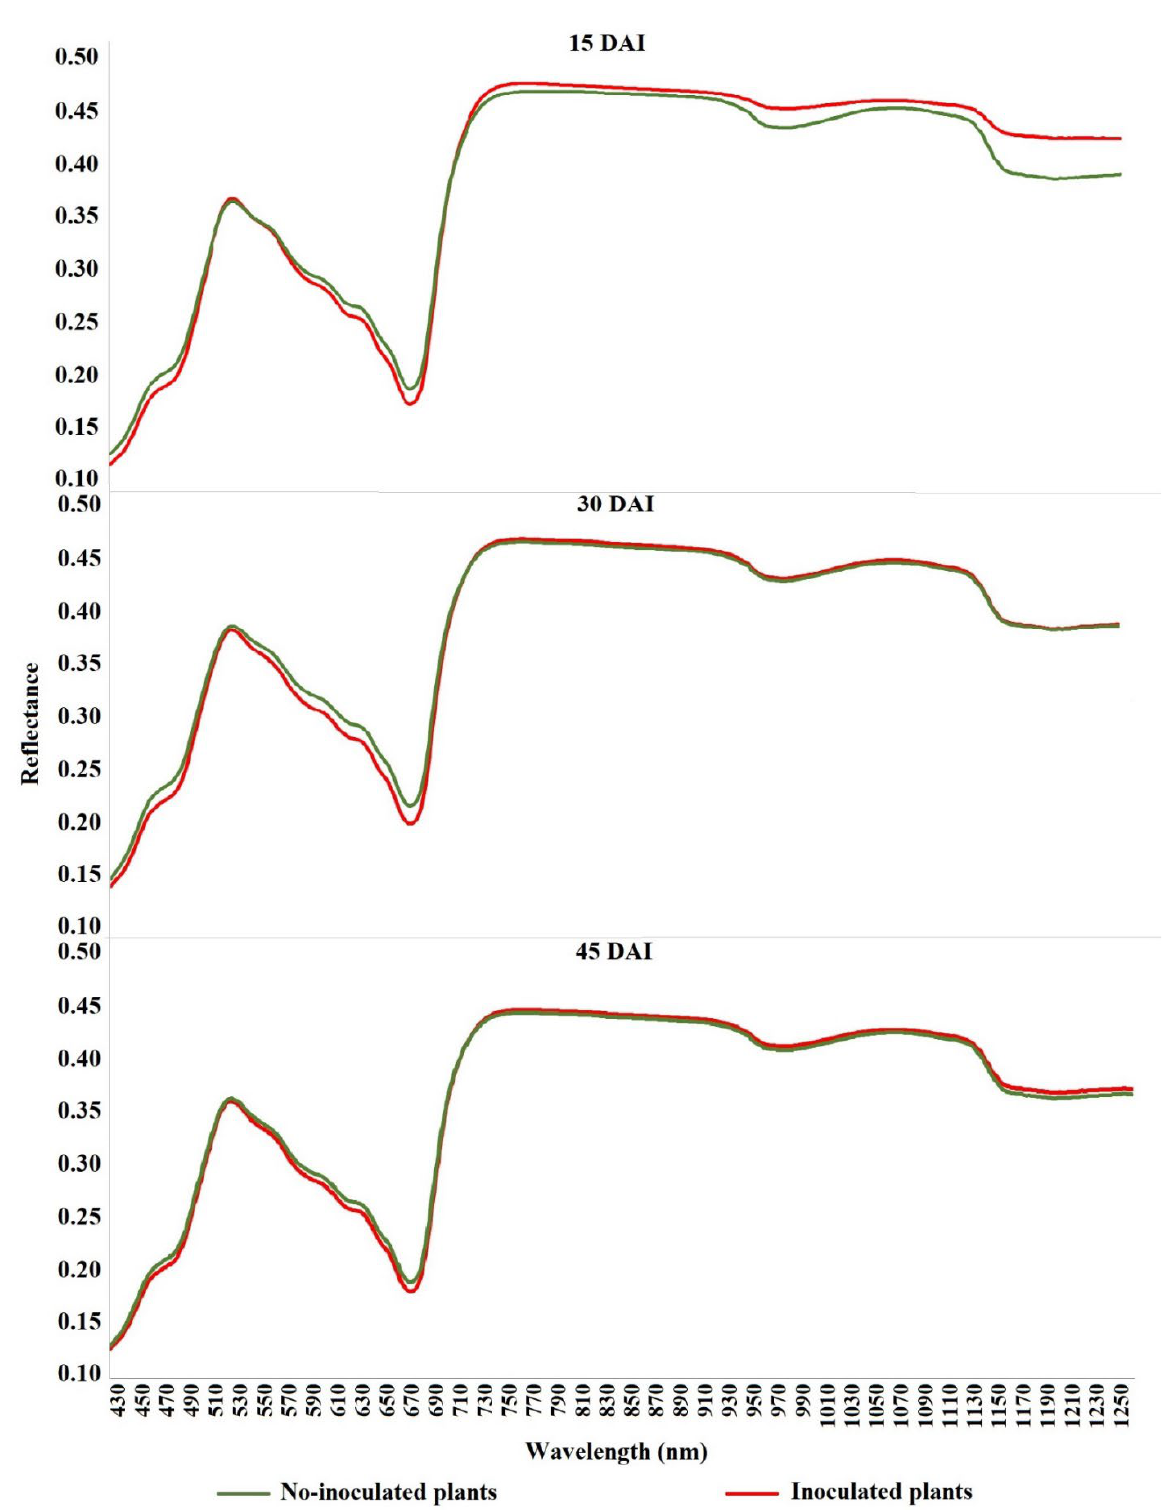
Figure 7. Average reflectance values of coffee seedlings after 15, 30, and 45 days after inoculation (DAI). The spectral curves diverged more in the visible band at 30 DAI (Figure 7). In the mid-IR and NIR bands, the curves showed less discrepancy. The inoculated seedlings showed 0.43% and 0.46% higher reflectance than the non-inoculated seedlings,